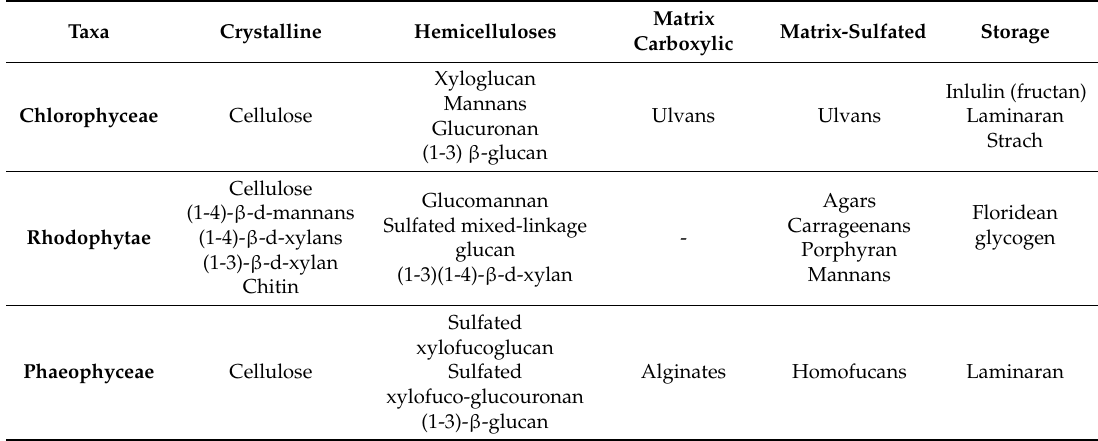
Table 1. Major cell wall and storage polysaccharides present in major macroalgal taxa